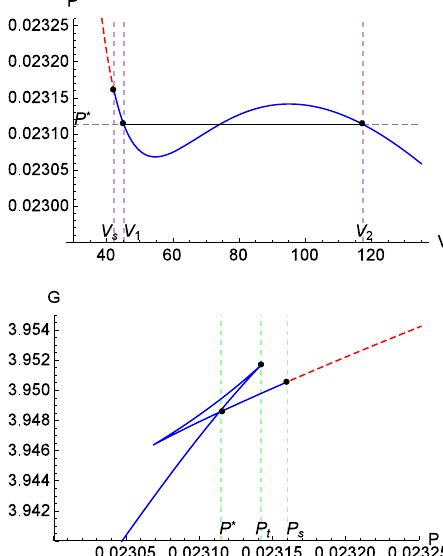
Fig. 3 P − V diagrams described by Eqs. (3.14) and (2.13) at q = − 2 and e = 2. Left The temperature takes the values of T = 0 . 08800 ( black ), T = T c = 0 . 08072 ( blue dotted ), T = 0 . 06650 ( orange ), T = 0 . 05364 ( purple dashed ), and T = 0 . 04800 ( green ), respectively. Middle The temperature takes the value of T = 0 . 07520, and for the